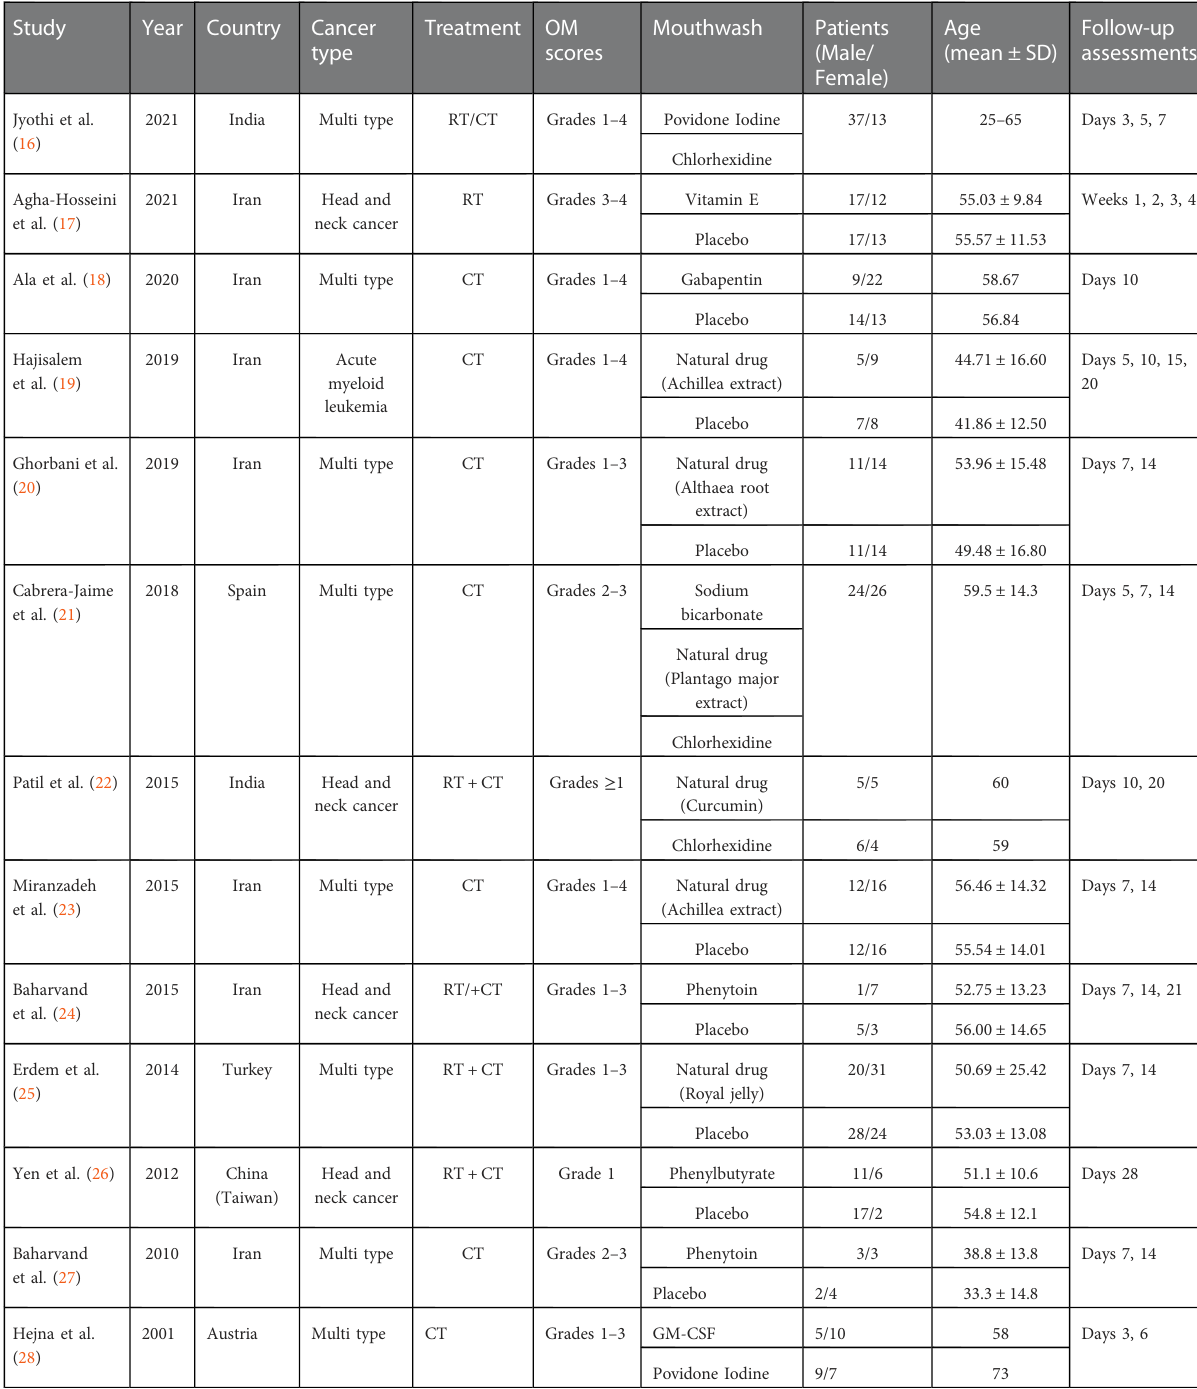
TABLE 1 Baseline characteristics of the trials included in this Bayesian network